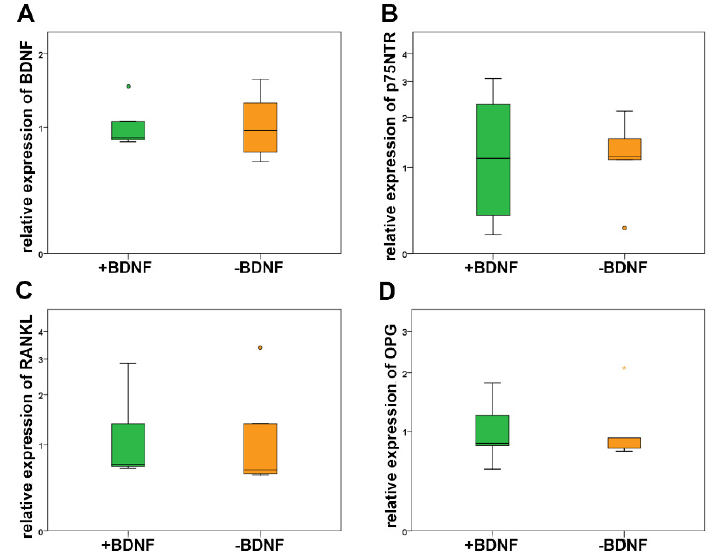
Figure 5. Real-time RT-PCR did not show significant differences in the relative expression of BDNF ( A ), p75NTR ( B ), RANKL ( C ), and OPG ( D ) in MLO-Y4 treated with BDNF compared to application without BDNF. Circles and colored asterisks indicate outliers.